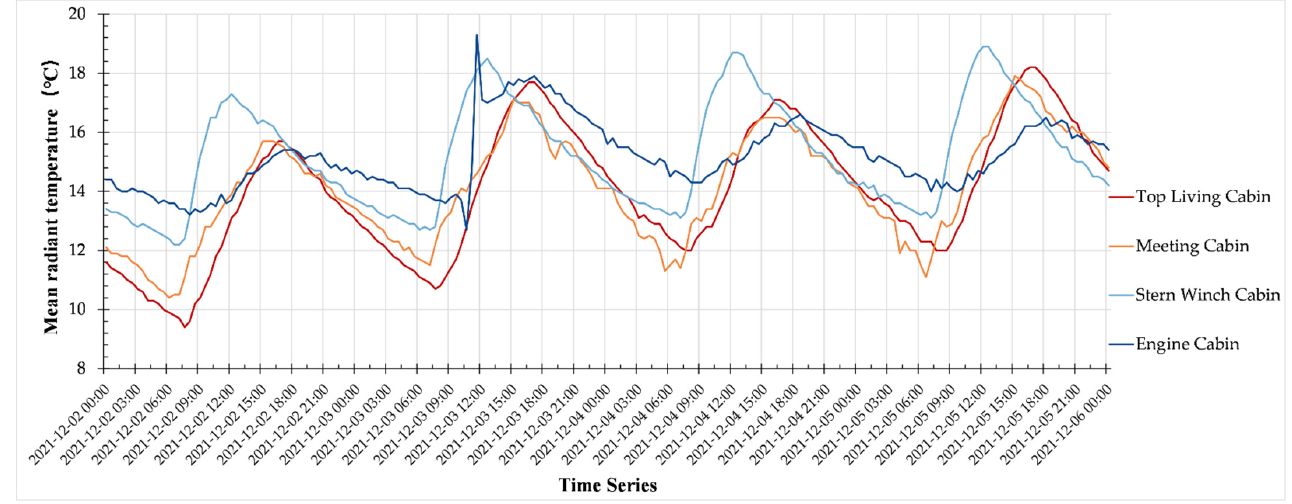
Figure 16. Mean radiant temperature in the ship between 2 and 5 December 2021.